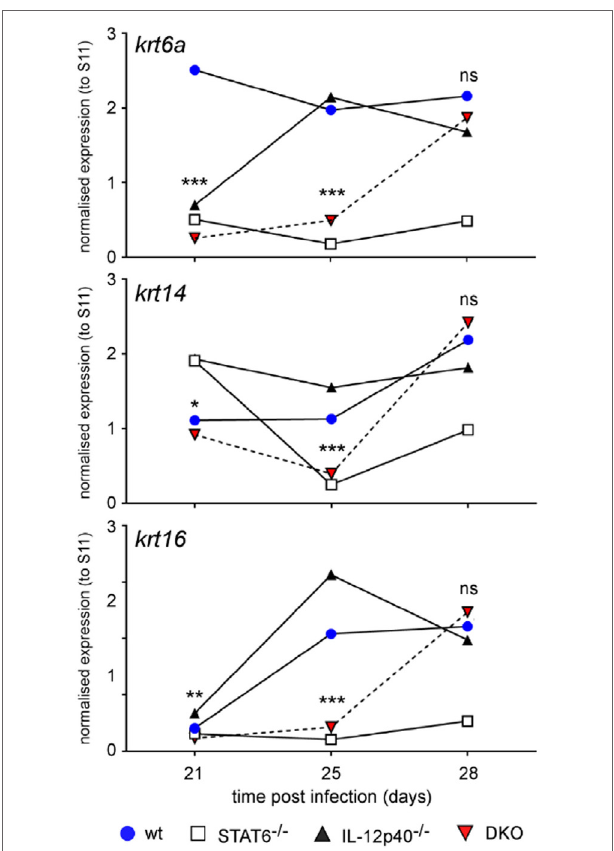
FigUre 2 | IL-12p40 − / − STAT6 − / − double knockout (DKO) mice show delayed expression of wound healing-associated keratinocyte markers. Wild type, IL-12p40 − / − , STAT6 − / − and DKO BALB/c mice were infected with 2 × 10 6 metacyclic promastigotes. RNA from naïve and infected mice was extracted from homogenized footpads at d21, d25, and d30 post-infection. Expression of the keratin 6a (krt6a), krt14, and krt16 genes were assessed and normalized to the expression of housekeeping gene rps11 . Data are representative of two different experiments with at least four footpads per group.